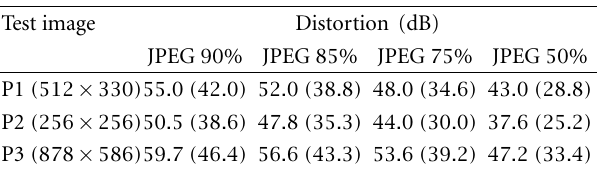
Table 2: Distortion for lossless embedding of 128 (4000)bits for three test images P1, P2, P3, and different JPEG quality